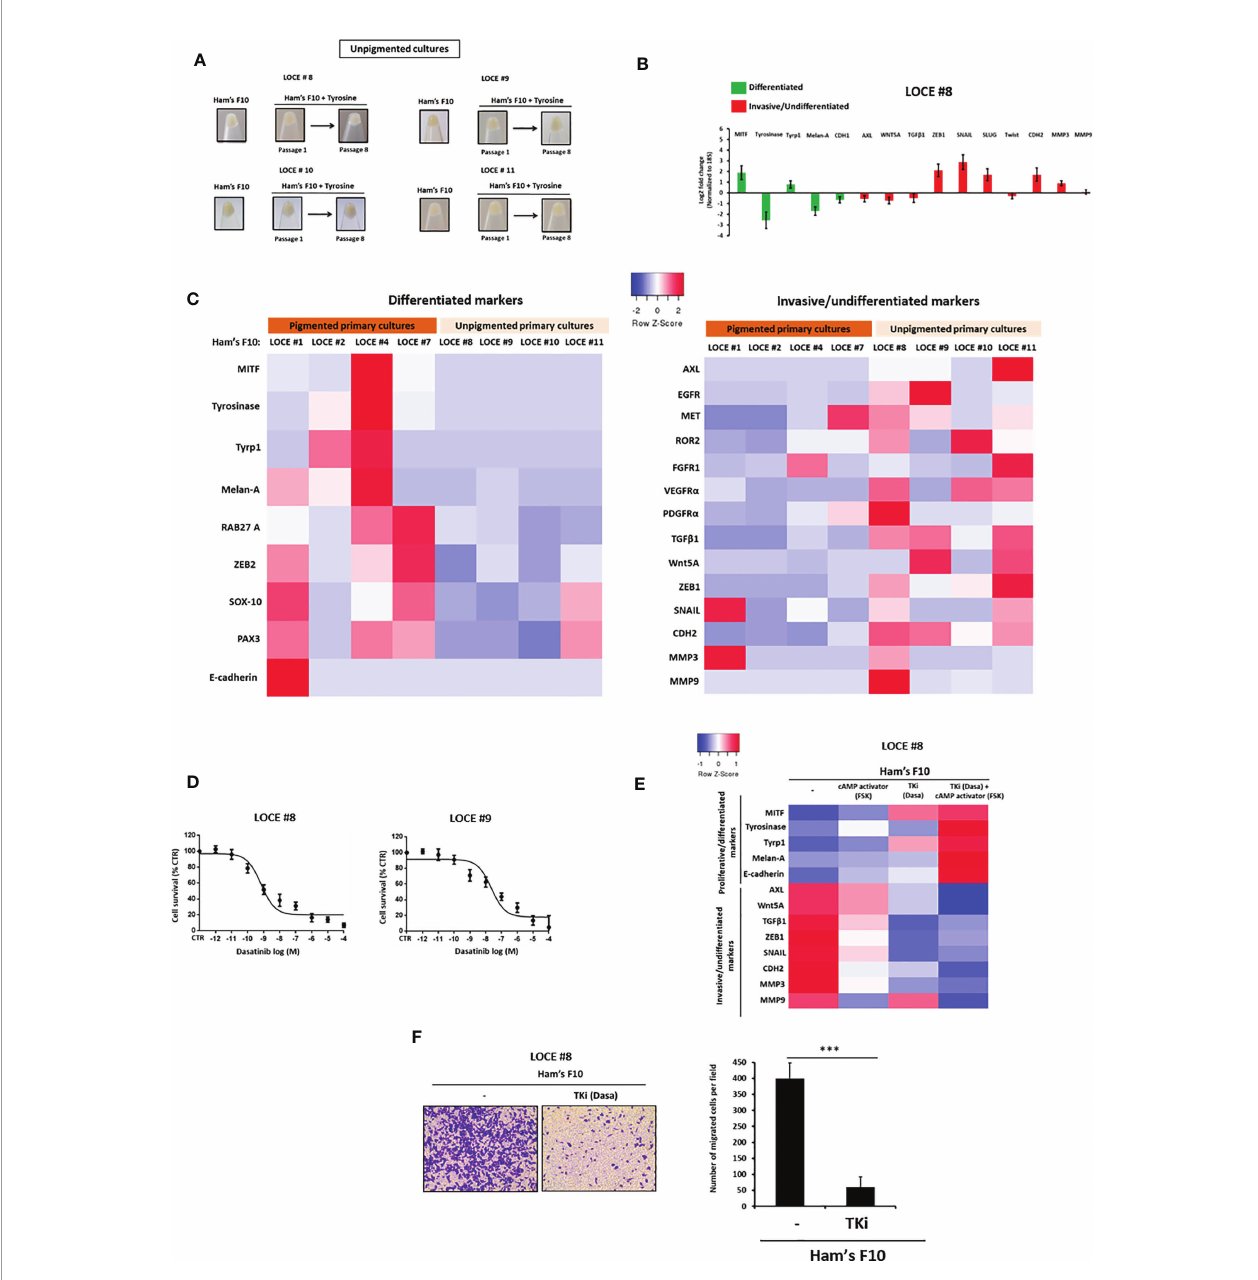
FIGURE 6 | Unpigmentedprimarycultureshaveaninherentinvasivephenotype,displayintrinsicresistancetoMAPKinhibitorsandincreasedvulnerabilitytoTKI. (A) Comparison ofvisiblepigmentationofcellpelletsfromfourprimarycultures(LOCE#8,9,10,and11)(unpigmentedcultures)beforeandfollowingexposuretohighconcentrationoftyrosineat passages1and8. (B) Log2-foldchangevaluesdeterminedbyRTqPCRofmaingenesimplicatedincelldifferentiation(melanocyticphenotype)(green)andundifferentiation/invasion (mesenchymal-likephenotype)(red)(passage8)inunpigmentedculture(LOCE#8)(FoldchangewascalculatedbasedongeneexpressioninHam ’